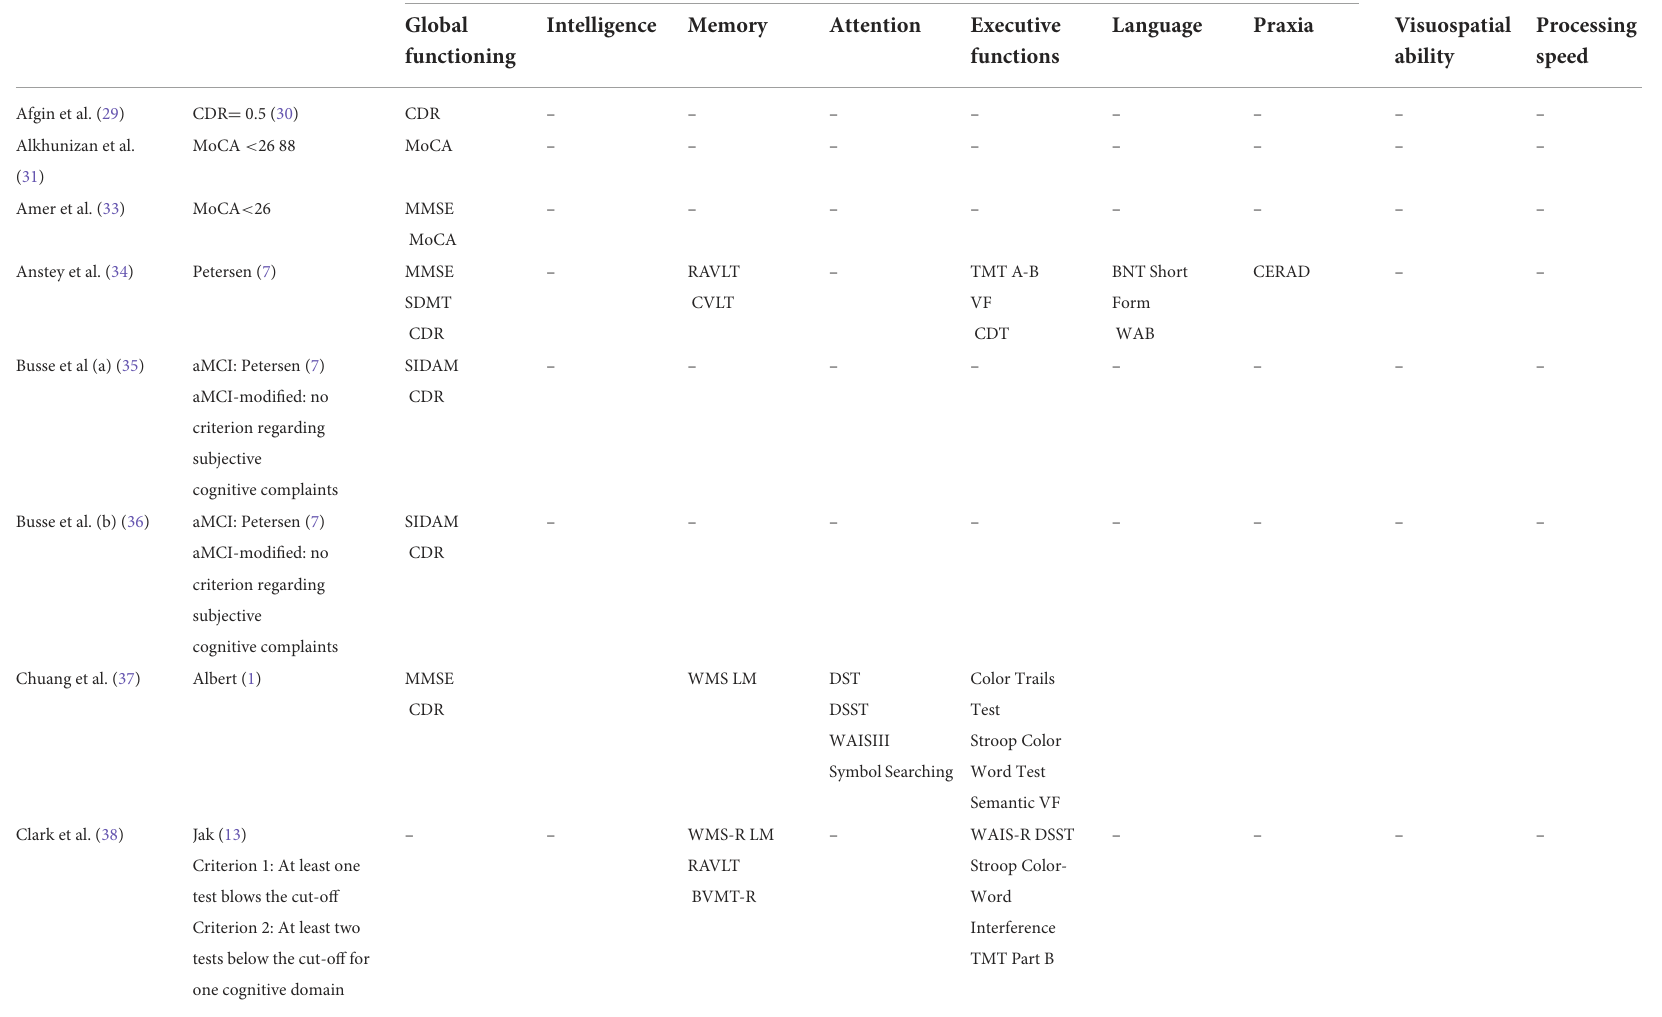
TABLE 4 Assessed cognitive domains and neuropsychological tests a